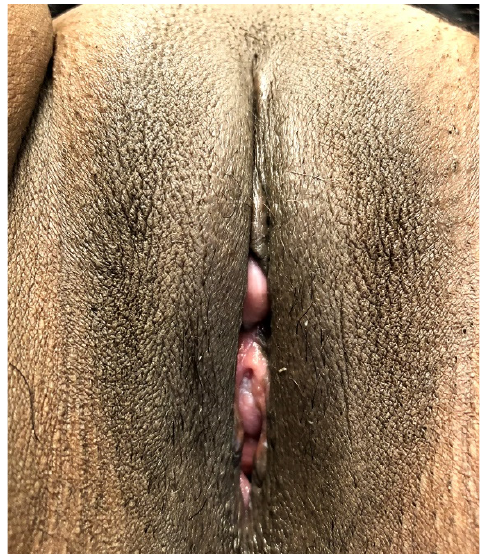
Figure 2. Three months after re-elevation of the clitoral stump and secondary epithelialization. Minimal vaginal showing without functional problems.